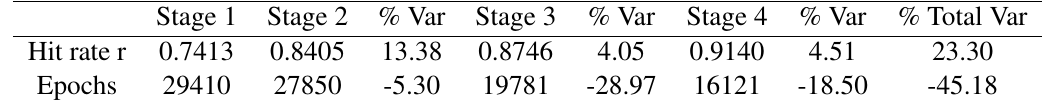
Table 13: Stage 4. Summary of the results obtained